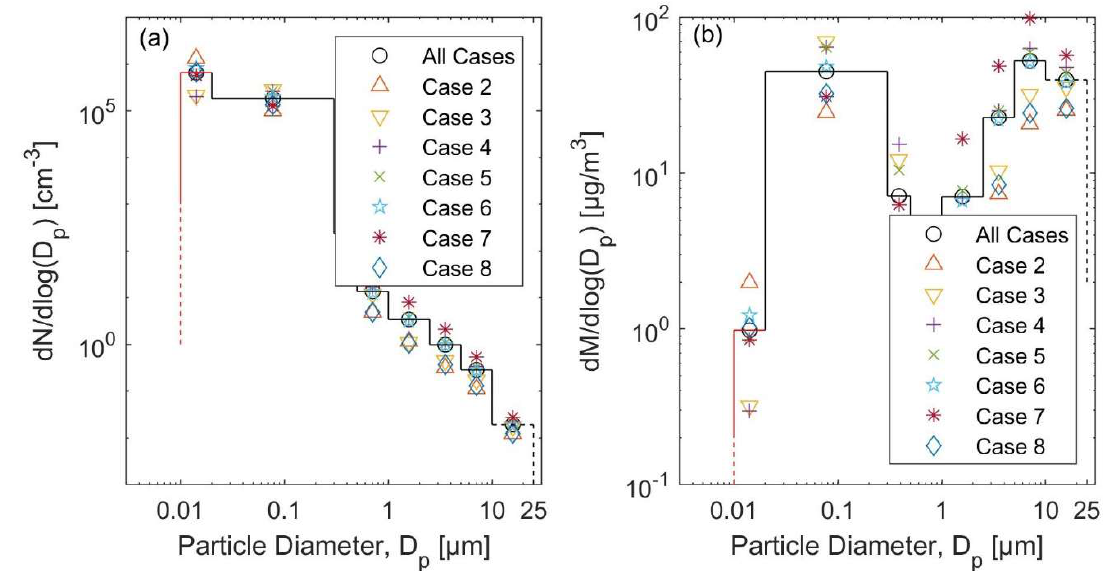
Figure 3. ( a ) Particle number size distributions observed during the kerosene heater operation and ( b ) corresponding particle mass size distributions.